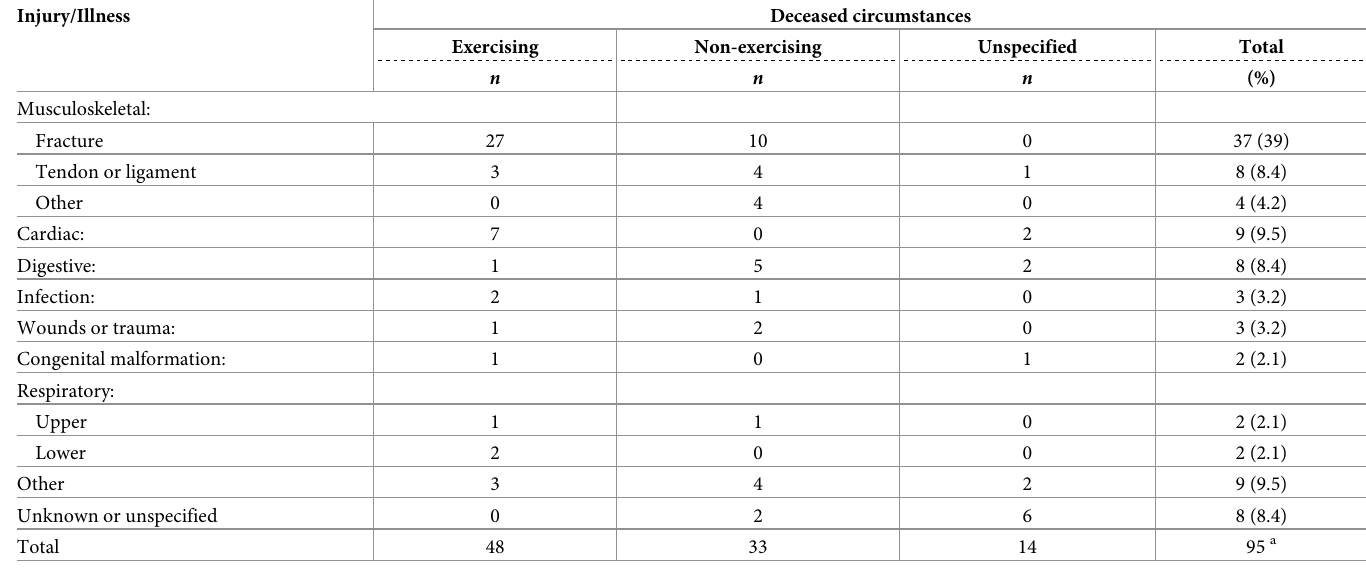
Table 6. Circumstances of death stratified by type of injury or illness for n = 93 survey horses that were reported as either died or euthanised, or sent to abattoir in the 2017–2018 Australian Thoroughbred racing season.